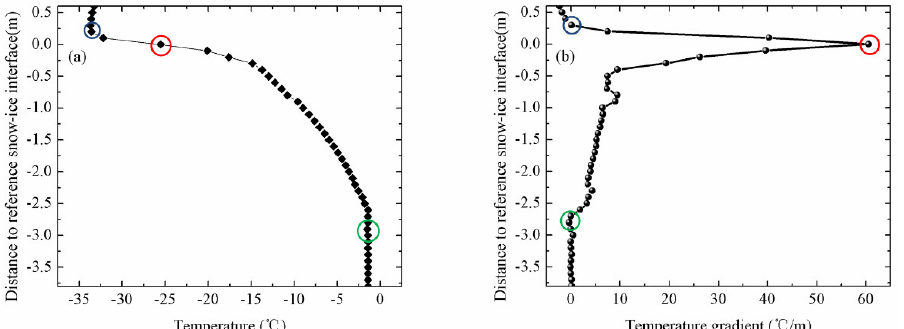
Figure 5. ( a ) Temperature profile of IMB-2007E on 20 December and ( b ) vertical gradients of temperature profile. The blue circle is the air-snow interface. The red circle is the snow-ice interface. The green circle is the ice-ocean interface.